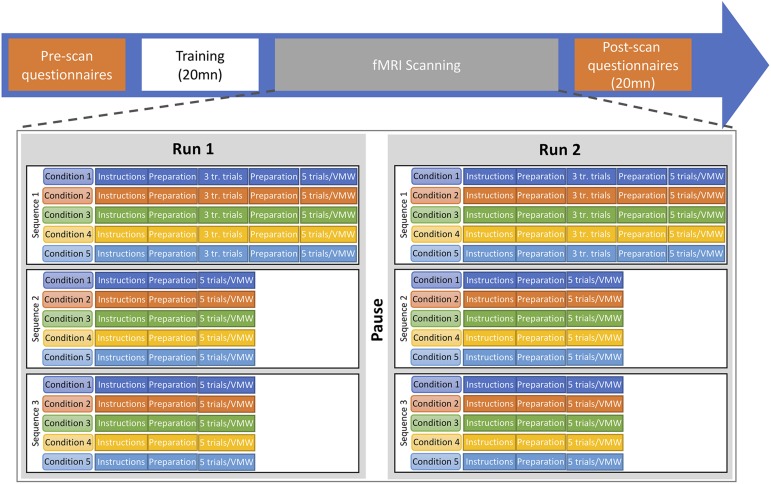
Timeline of the experimental procedure. Two functional runs were completed, each including the five conditions. Each run included three repetitions of the sequence of five conditions. In each repetition, five trials of the MS, MO, DO, and SP conditions were elicited as well as one VMW session. tr. trials, training trials.